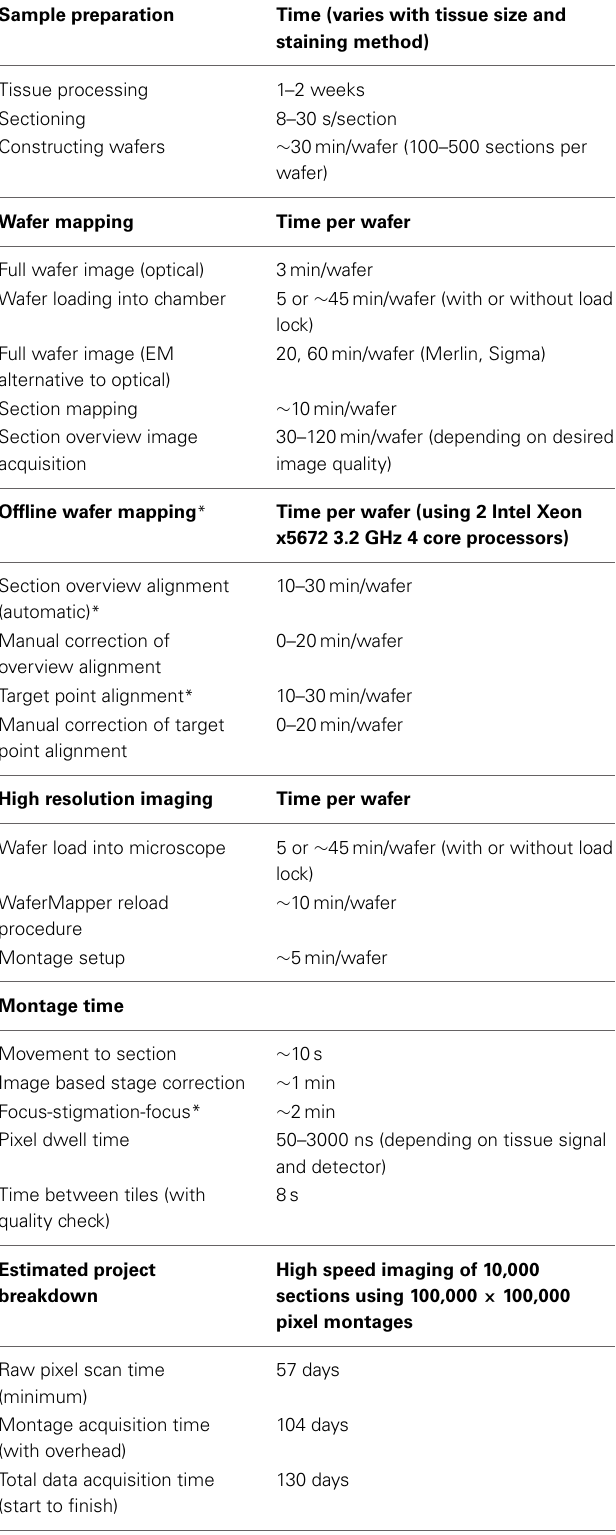
Table 1 | Breakdown of the time required for each step of data acquisition using ATUM-SEM and